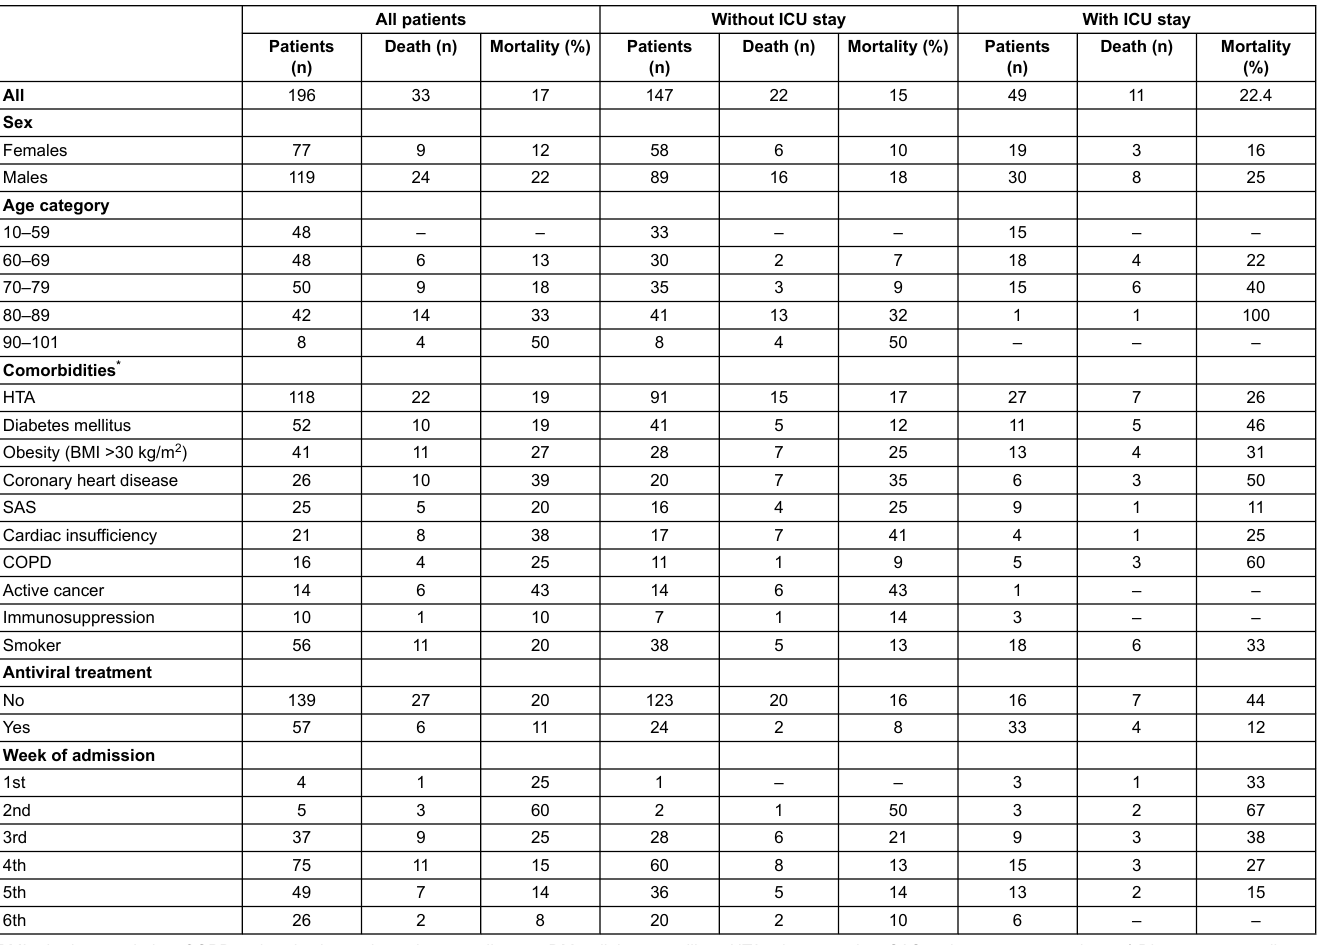
Table 3: In-hospital mortality for all patients, patients with and without ICU stay.